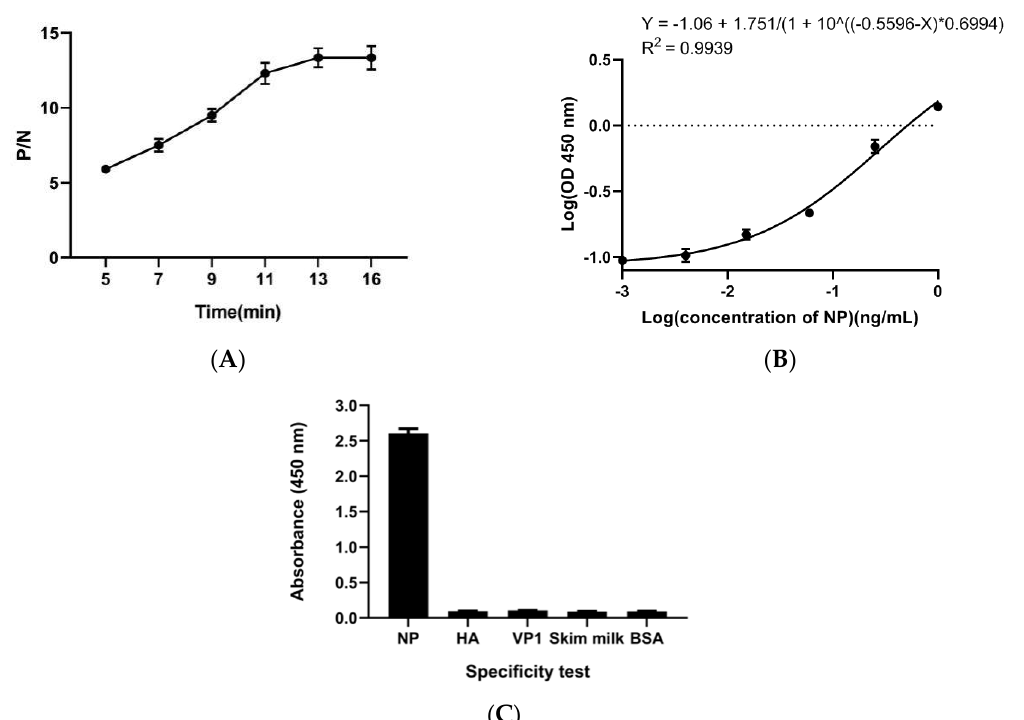
Figure 4. AuNP-based enzyme-linked immunosorbent assay (ELISA). ( A ) Optimization of color development time under optimized conditions in Table 1, and ( B ) calibration curve for the absorbance versus concentration of NP from 0.00025 ng mL − 1 to 1.0 ng mL − 1 . The absorbance intensity as the ordinate and the concentration of NP as the abscissa. ( C ) Specificity test. The specificity test was completed with NP (3.9 ng mL − 1 ), BSA, skim milk, viral protein 1 of Enterovirus D68 (VP1), and